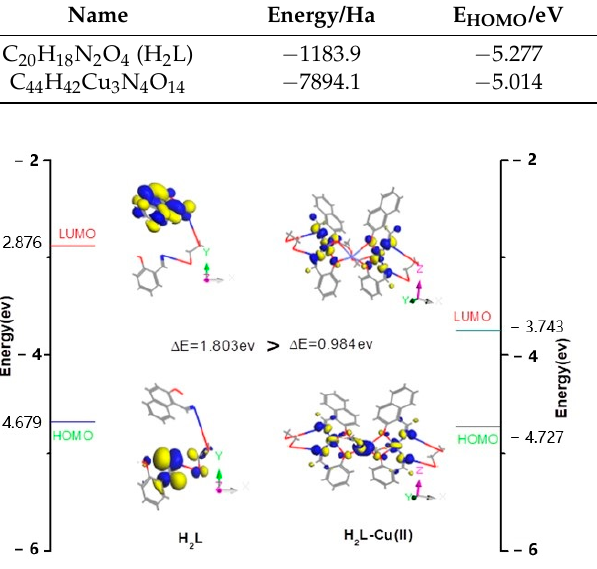
Figure 5. Surface plots of HOMO-LUMO of H 2 L (left) and its Cu II complex (right). Table 5. Frontier molecular orbital energies and molecule energies of H 2 L and its Cu II complex.